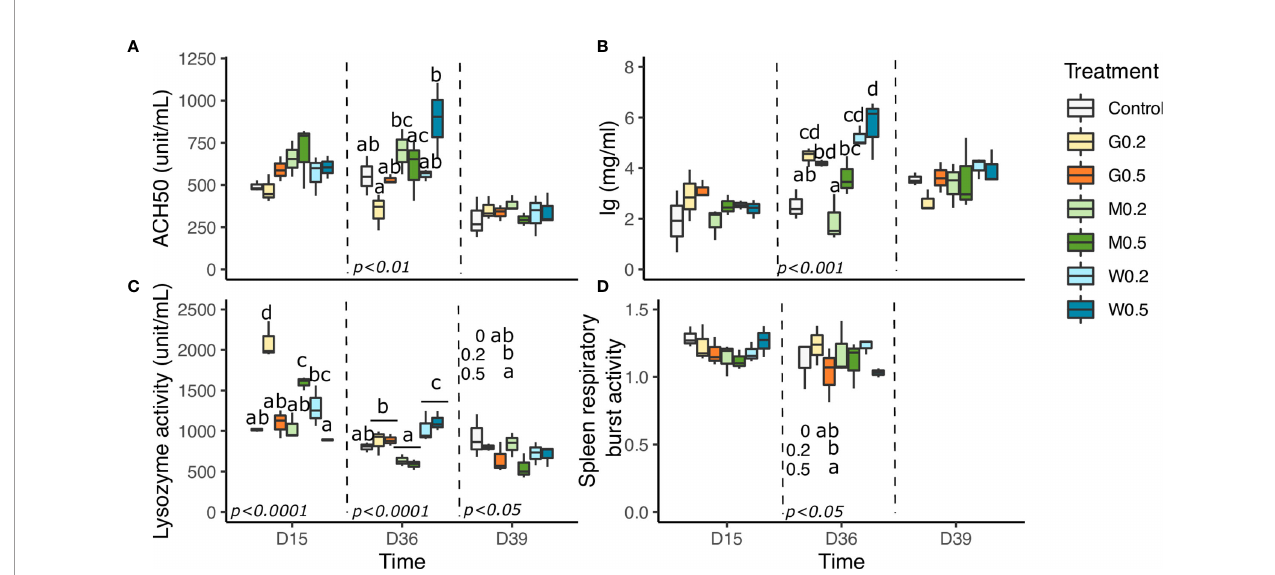
FIGURE 1 | Effects of dietary beta glucan administration on humoral parameters of fi sh sampled during the nutrient test on D15 and D36, or 2 days after bacterial infection (D39). (A) Plasma hemolytic alternative complement activity. (B) Plasma total immunoglobulin ’ s content. (C) Plasma lysozyme activity. (D) Respiratory burst activity (RBA) of spleen macrophage cells. Values are expressed as mean ± SD of 18 fi sh/diet/day on D15, D36 and 9 fi sh/diet on D39. For spleen respiratory burst activity (RBA), plasma hemolytic alternative complement activity (ACH50) data are expressed as mean ± SD of 9 fi sh/diet/day on D15, D36. Statistical differences between groups are indicated by different letters Statistical differences, highlighted by letters, are indicated for glucan concentrations in front of 0, 0.2, and 0.5% next to the corresponding plot, for glucan type by letter above the horizontal bar grouping the two doses of the same glucan, for glucan type × concentrations interactions above each box. P values are shown at the bottom of each graph at a given timepoint (D15, D36, or